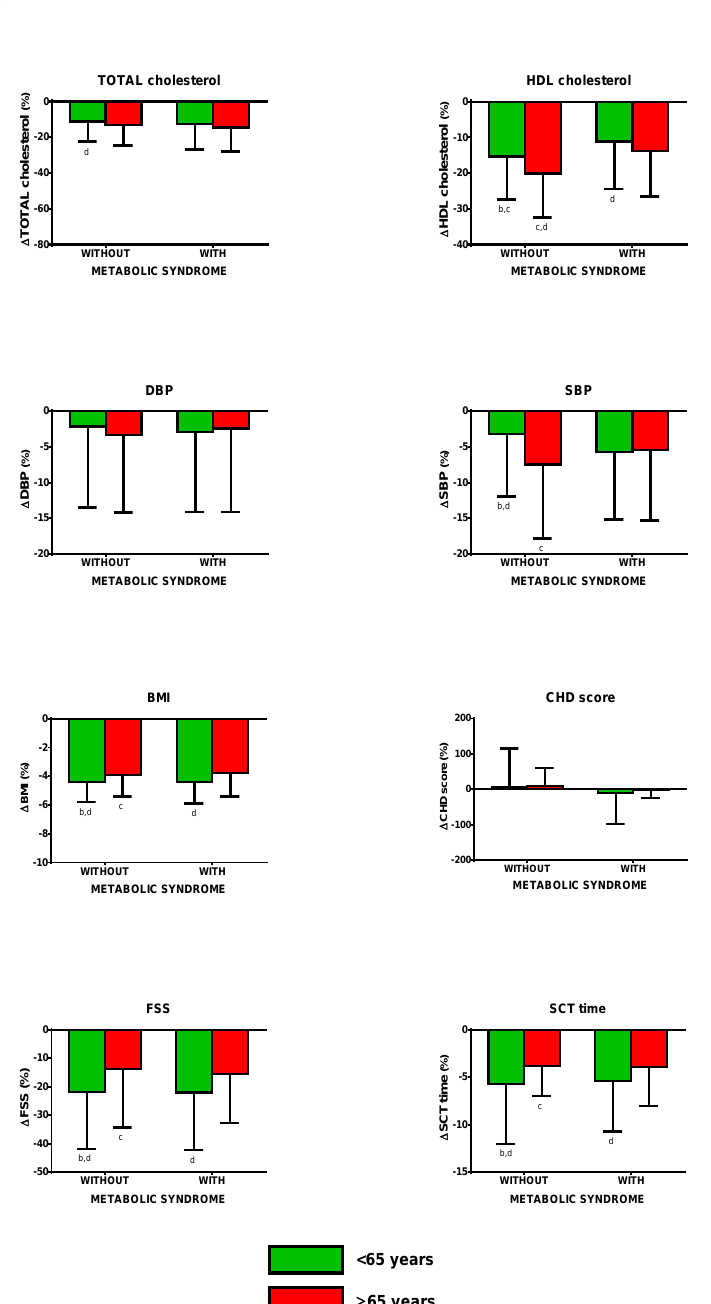
Figure 3. Changes of total cholesterol, HDL cholesterol, diastolic blood pressure (DBP), systolic blood pressure (SBP), body mass index (BMI), coronary heart disease (CHD) score, fatigue severity score (FSS), and stair climbing test (SCT) time, before and after a three-week body weight reduction program (BWRP) in obese